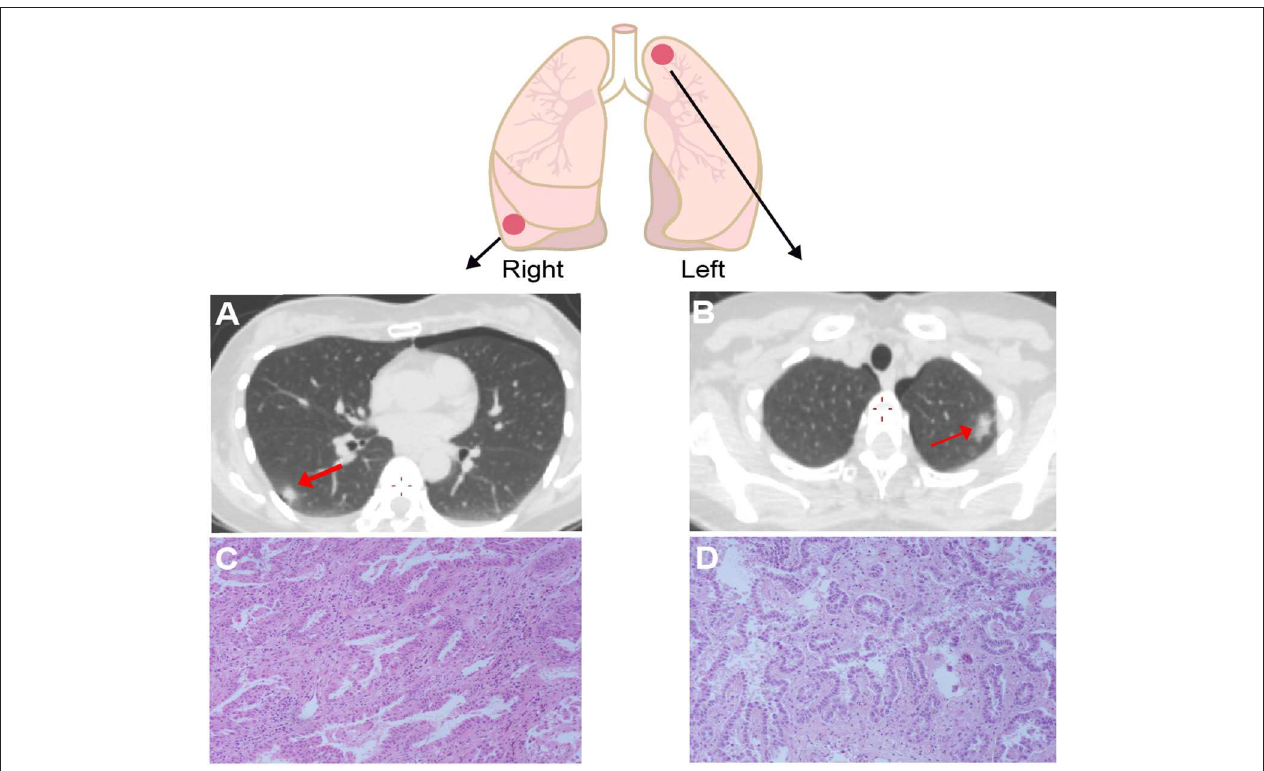
FIGURE 1 | Computed tomography (CT) and Hematoxylin & eosin (HE) staining for the lesion in right lower lobe (A,B) and left upper lobe (C,D) showed both of the tumors are well-differentiated adenocarcinomas. The right one has papillary-predominant pattern, and the left one appeared with acinar-predominant and lepidic pattern. Red arrows point the tumor